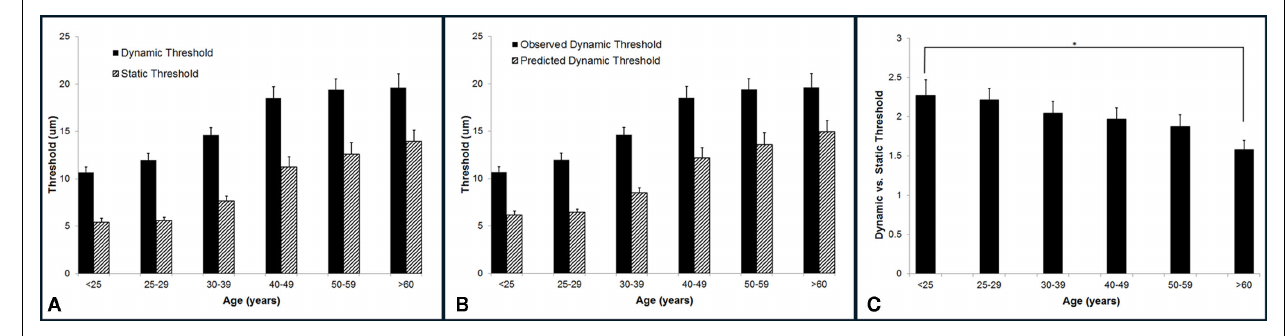
significantly smaller than the observed thresholds. (C) Summary of ratio of dynamic vs. static detection threshold across six age groups. Not only the dynamic threshold is always greater than the static threshold, but the dynamic vs. static ratio decreases with age.There is a significant difference between the youngest age group and the oldest age group ( p < 0.5).